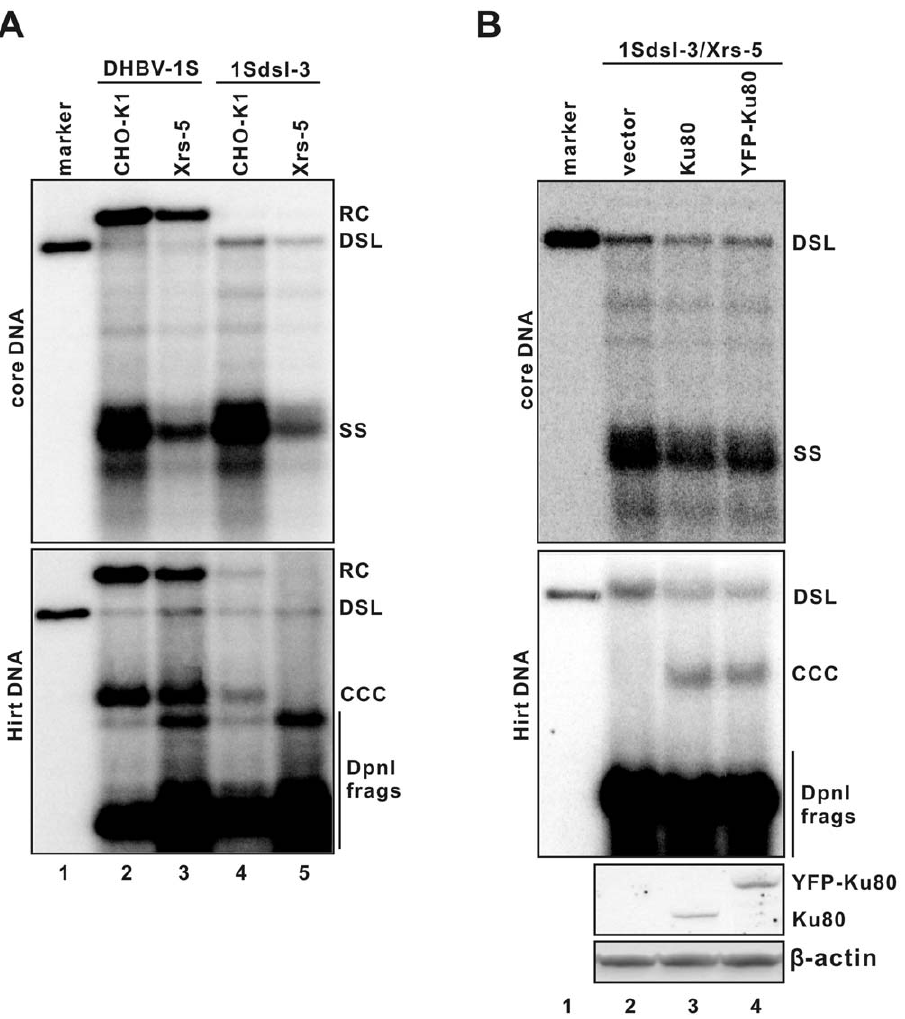
Figure 4. Role of Ku80 in DHBV cccDNA formation from dslDNA precursors. (A) CHO-K1 and Xrs-5 cells were transfected with plasmid DHBV-1S or 1Sdsl-3, respectively. On the day five post transfection, the cells were harvested and DHBV core-associated (upper panel) and Hirt DNA (lower panel) were extracted and analyzed by Southern blot hybridization. Unit-length DHBV genomic DNA served as a molecular weight control. (B) Xrs-5 cells were co-transfected with plasmid 1Sdsl-3 and vector plasmid pUC119 (lane 2), plasmid expressing wild-type Ku80 or Ku80-YFP fusion protein, respectively. The cells were harvested on day 5 post transfection. Core (upper panel) and Hirt (middle panel) DNA were detected by Southern blot hybridization. Ku80 and Ku80-YFP expression were detected by Western blot assay (lower panel). b -actin served as a loading